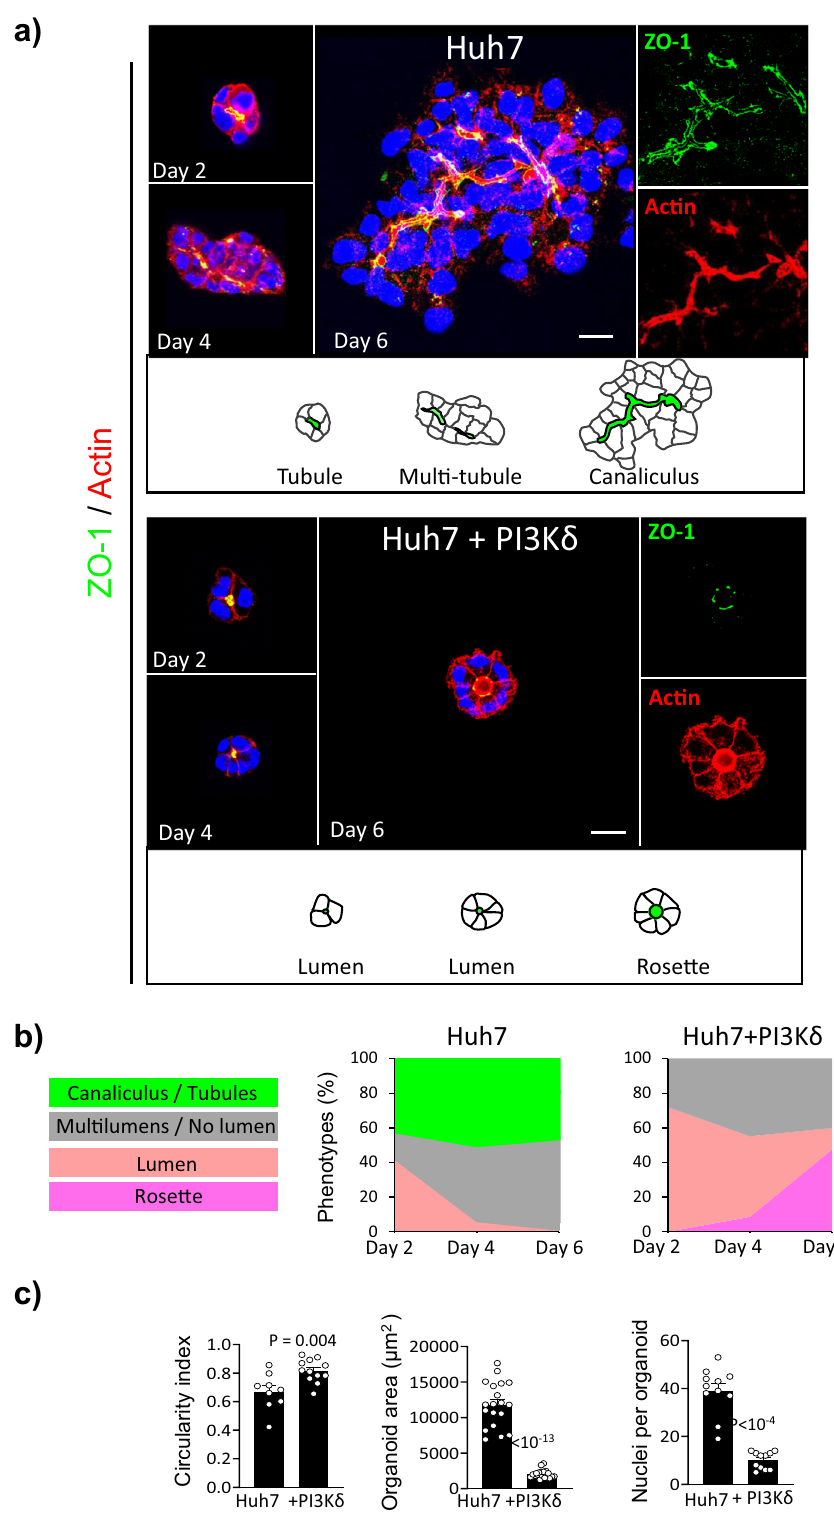
Fig. 1 PI3K δ is required for bile canaliculi formation and its overexpression induces formation of rosette-like structures. a Time-course analysis of lumen formation in Huh7 and Huh7 overexpressing PI3K δ (Huh7 + PI3K δ ) organoids plated in 3D Matrigel-matrix and stained after 2, 4 or 6 days for Zonula-occludens 1 (ZO-1, green), actin micro fi laments using phalloidin (red) and nuclei using Hoechst (blue). Scale bar: 10 μ m. b Quanti fi cation of the phenotypes percentage over the days of culture of Huh7 ( n = 117 organoids) and Huh7 + PI3K δ ( n = 123 organoids). c Quanti fi cation of Huh7 and Huh7 + PI3K δ circularity index, organoids area and nuclei per organoid. Each dot of the graph corresponds to an organoid. All values are expressed as mean ±